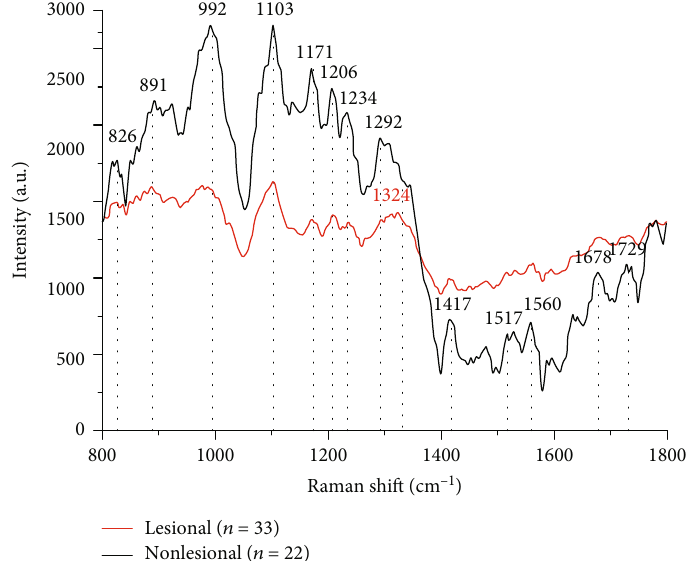
Figure 5: Mean Raman spectra of 33 EGC tissue specimens (red line) and 22 nonlesional tissue specimens (black line).